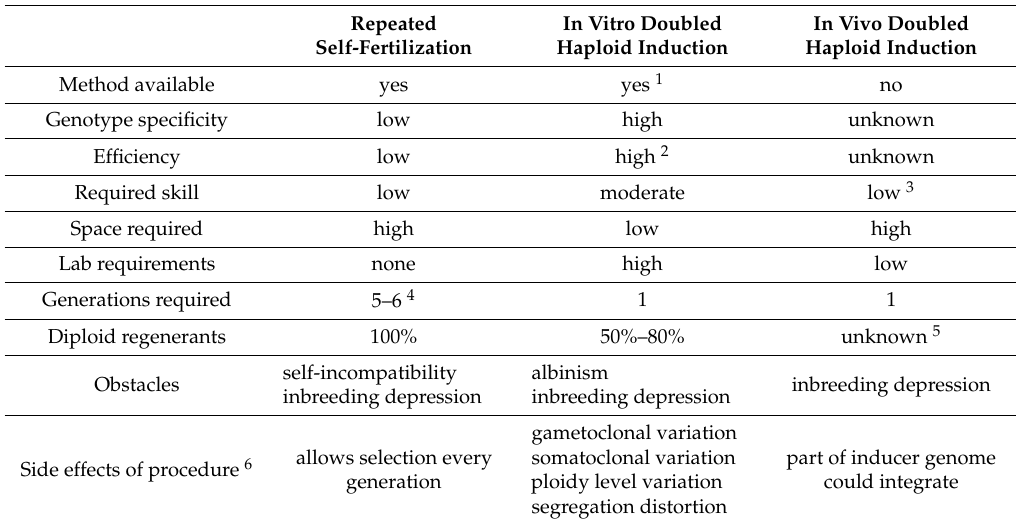
Table 1. Comparison of three methods to obtain inbred or 100% homozygous lines in perennial ryegrass.